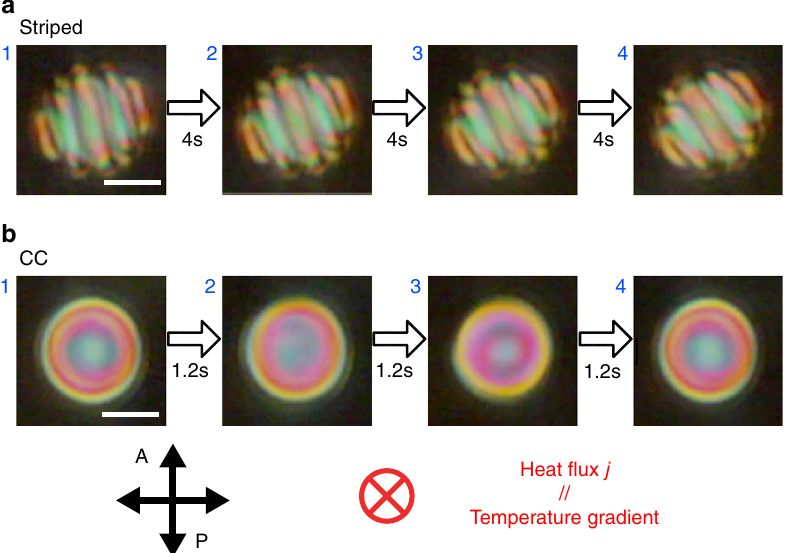
Fig. 3 Snapshots of HIR of conventional-type droplets. The droplets are formed in the Iso-Ch coexistence region of a non-dispersed mixture of E8 and 5CB + 1.0 wt% chiral dopant. Scale bars, 10 μ m. The time intervals between the snapshots for a and b are 4 and 1.2 s, respectively. The temperature is stationary at 55 °C. The heat fl ux is in the viewing direction, shown by the red cross symbol ( j = 6.0 mW mm − 2